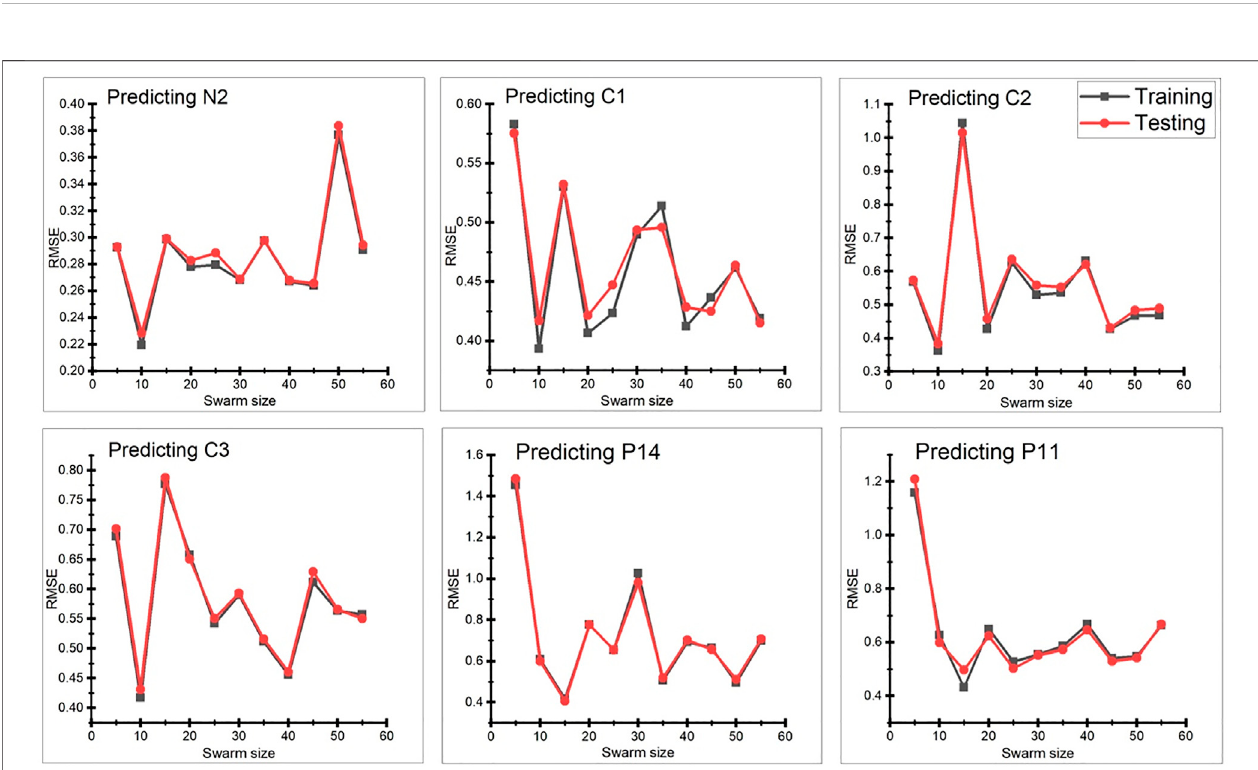
FIGURE 5 | Calculation of optimum swarm sizes with respect to